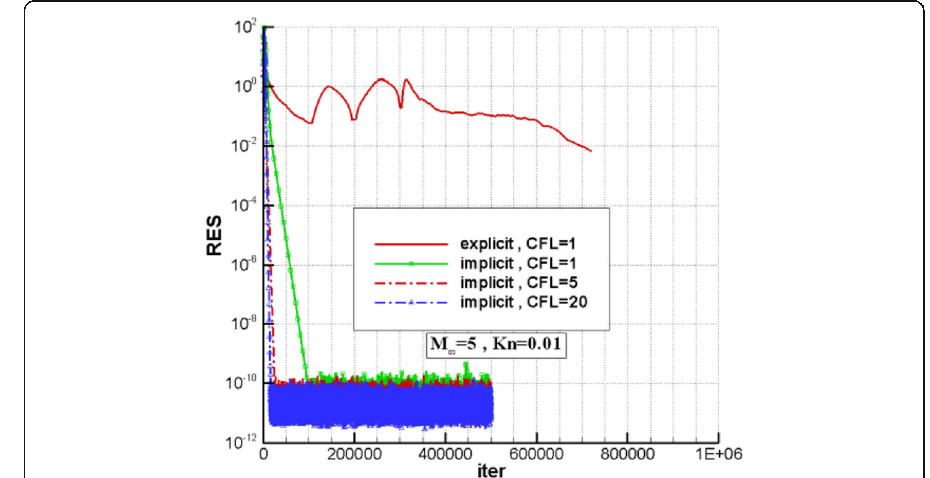
Fig. 11 Convergent histories of the residual with Ma = 5.0 and Kn =